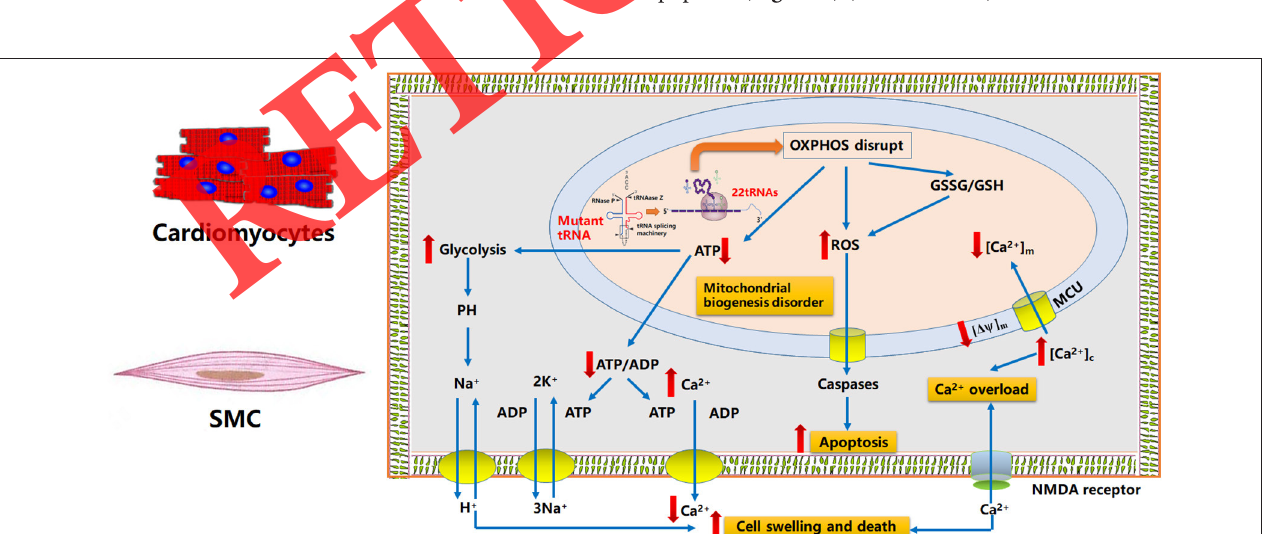
FIGURE 3 | Potential mechanisms involved in tRNA mutation-associated EH, altered ROS synthesis, and ATP synthesis defects. MtDNA mutation leads to decreased tRNA expression, inhibition of mitochondrial OXPHOS-related protein synthesis, increased mitochondrial oxidative stress, increased cell apoptosis, leading to vascular remodeling. Dysfunctions of OXPHOS in mitochondria lead to abnormal energy metabolism and abnormal changes in the exchange of sodium and calcium, leading to calcium overload in the cytoplasm, diastolic dysfunction of cardiomyocytes and smooth muscle cells, and promoting blood pressure increase.